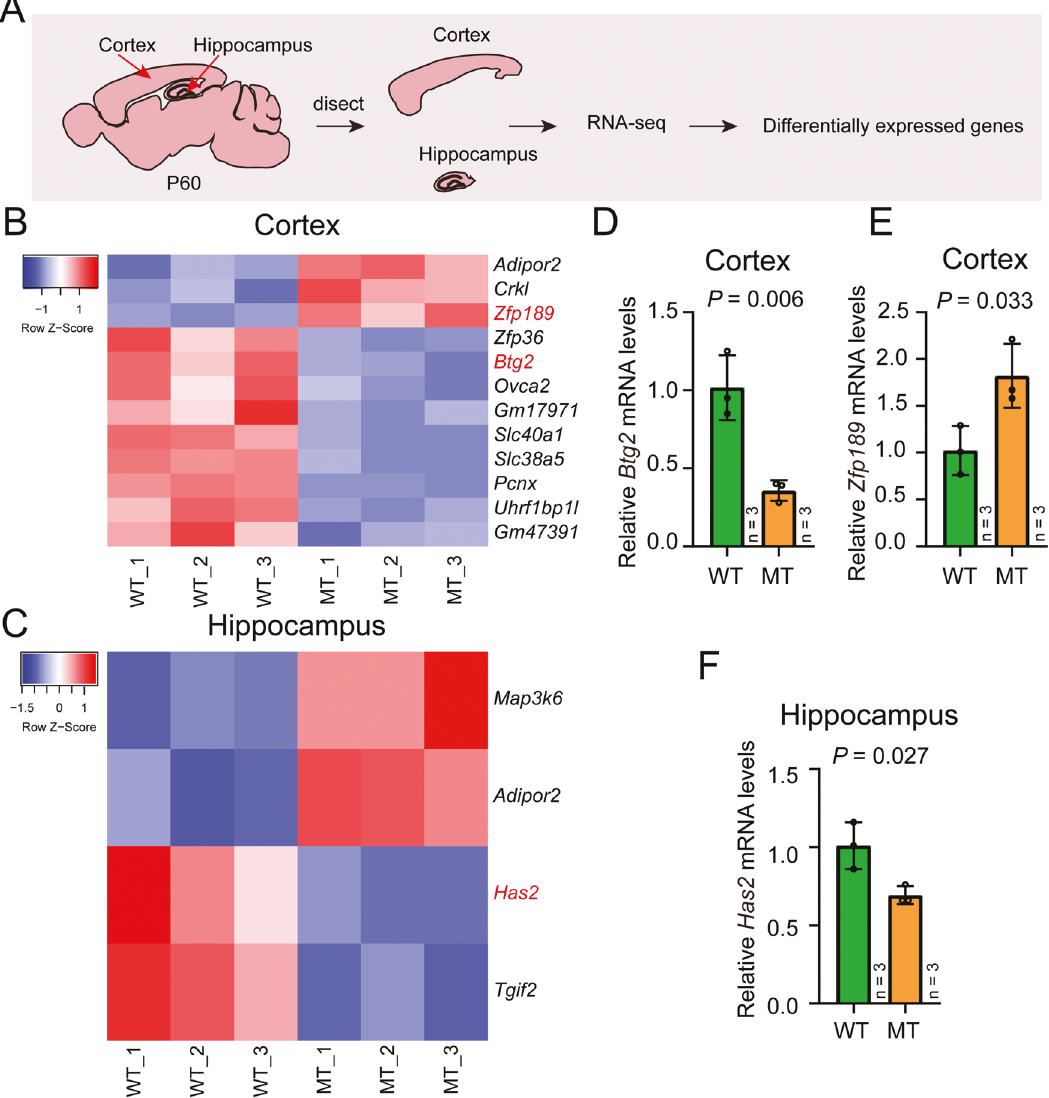
Fig. 4 Impact of SLC39A8-p.393T knock-in on gene expression in the cortex and hippocampus. A Overview of transcriptome analysis. B , C DEGs identi fi ed in the cortex and hippocampus of SLC39A8-p.393T knock-in and wild-type mice, respectively. D – F qPCR validation of the RNA sequencing. Two-tailed Student ’ s t - test was used for statistical test. Data represent mean ± SD, n = 3 for D – F